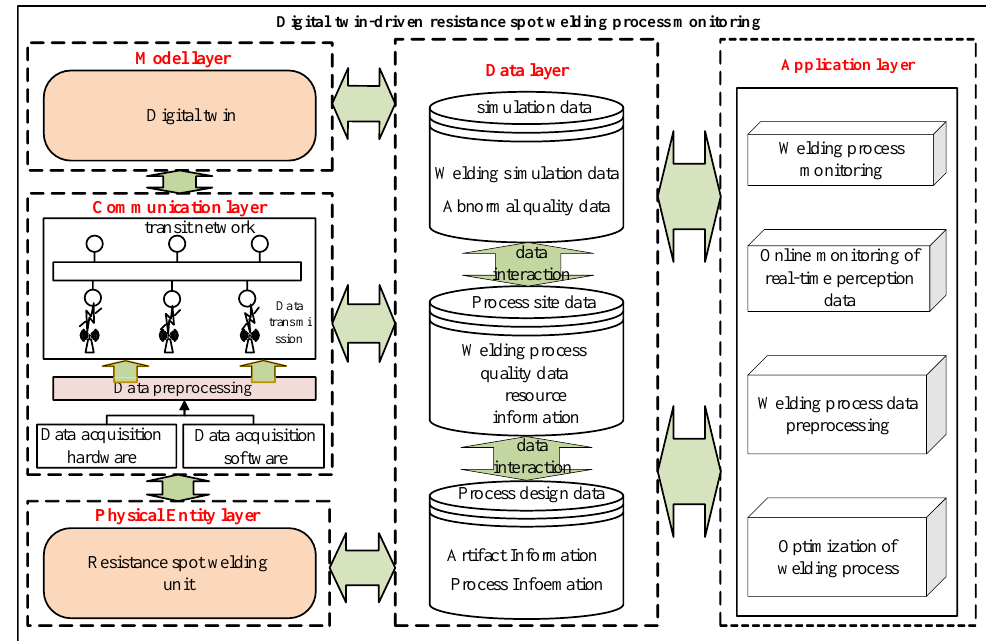
Figure 1. Framework of a digital twin system for the resistance spot welding process.